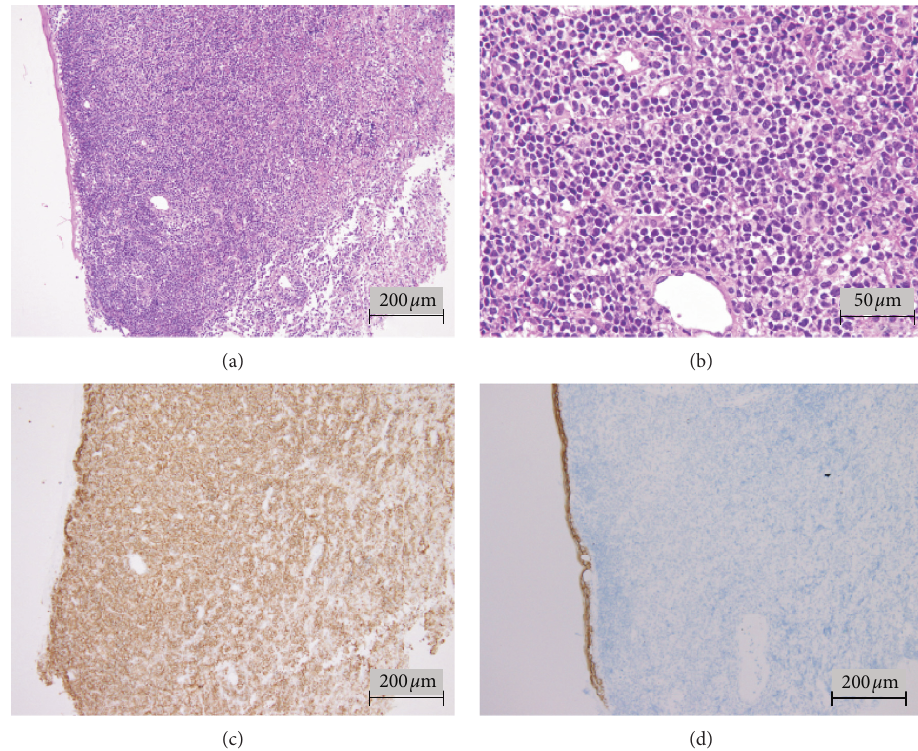
Figure 1: Hematoxylin and eosin- (H&E-) stained section of nasal mucosa (a, b). Immunohistochemical staining of CD20 (c) and CD138 (d). H&E staining showed diffuse proliferation of atypical lymphoid cells with prominent nucleoli and clear cytoplasm (a, b). Immu- nohistochemical staining revealed that atypical cells were positive for CD20 (c) and negative for CD138